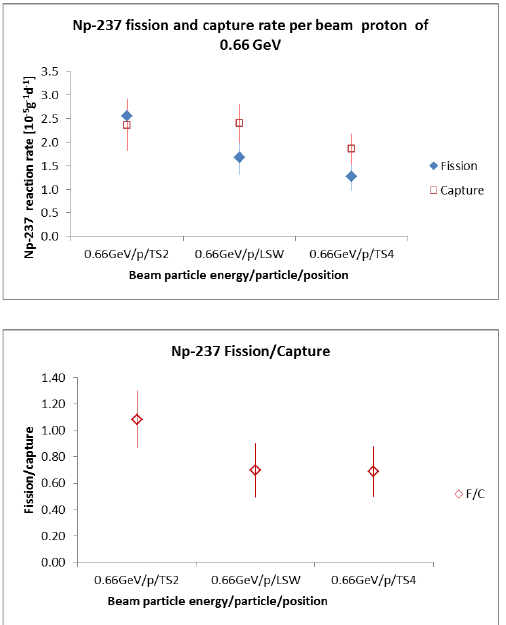
Table 1. Sample Np-237-identified gamma lines and their data. FP – fission product. CP –